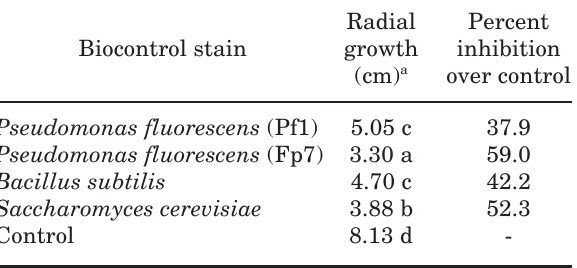
Table 1. Antagonistic effect of biocontrol strains against Colletotrichum gloeosporioides under in vitro conditions